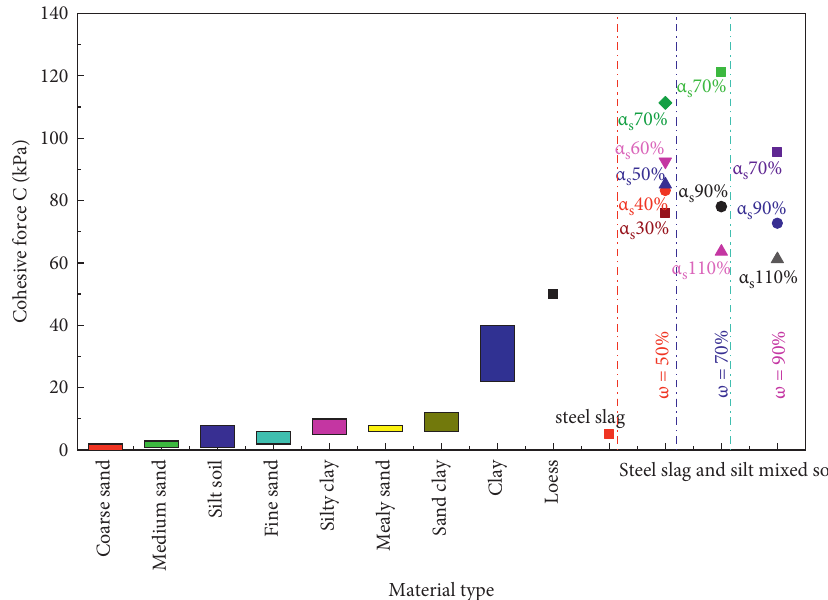
Figure 16: Cohesive force of mixture and different traditional soil.